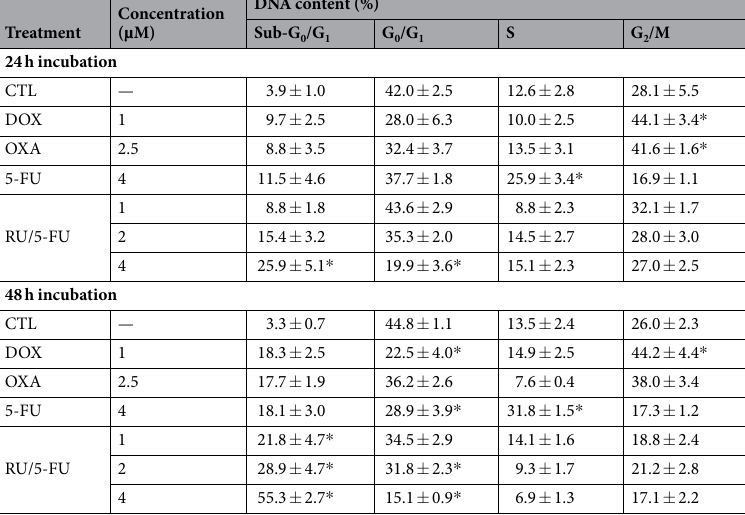
became more pronounced at highest concentration and at longest time of incubation. No accumulation of cells in any phase of the cell cycle was observed. On the other hand, 5-FU treatment resulted in a significantly increase in the number of cells in S phase compared to the negative control (30.7% at control against 54.0% at 5-FU after 24 h incubation; and 23.8% at control against 40.8% at 5-FU after 48 h incubation, respectively). Doxorubicin and